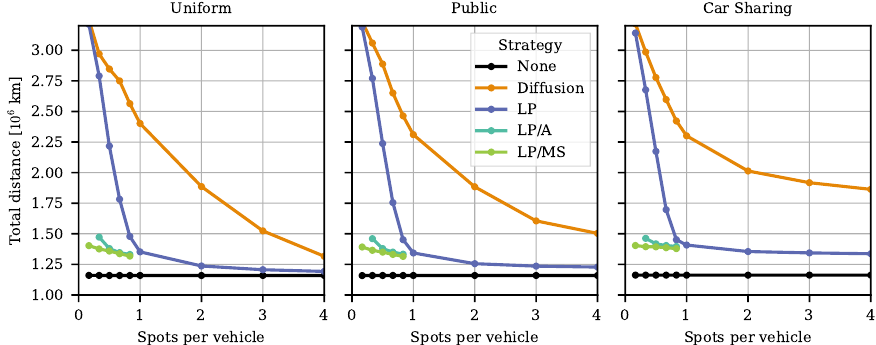
Figure 2. Evolution of the vehicle distance traveled for the different strategies depending on the number of parking spaces. (A = Depot at airport; MS = depot at the main station).